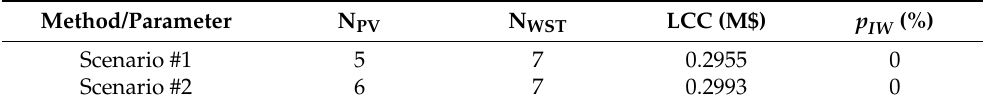
Table 10. Results of Scenarios 1 and 2.